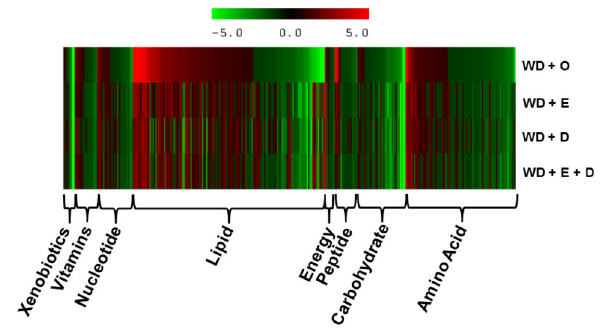
Figure 1. Heat map of diet effects on liver. The heat map represents the fold-change for each metabolite relative to control chow-fed versus WD-fed mice. The WD was supplemented with olive (O), EPA (E), DHA (D) or EPA and DHA (E + D). Results are sorted by fold-change within each pathway.